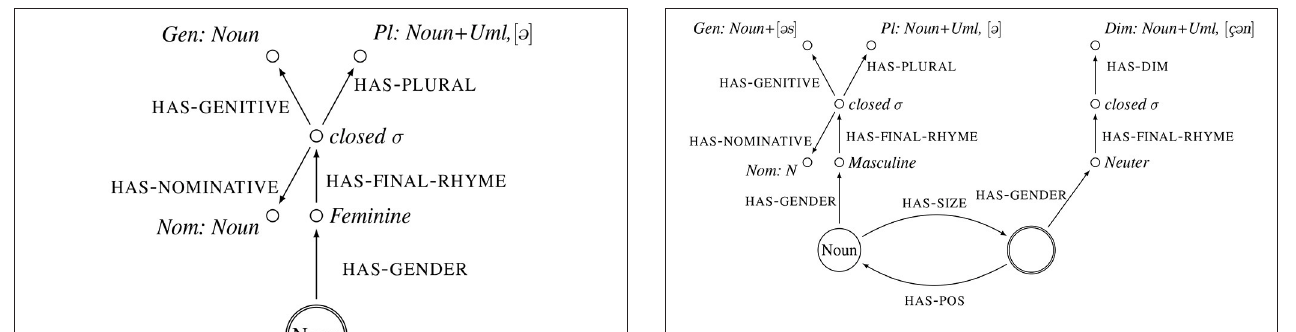
FIGURE 5 | Frame representation the diminutive of the noun [ bA5t ] “beard” and the inflected formed of the paradigm of the plain, non-diminutive word. The central node of the frame of the diminutive is the Size-of-N. TABLE 1 | The noun types of the inflectional class in our